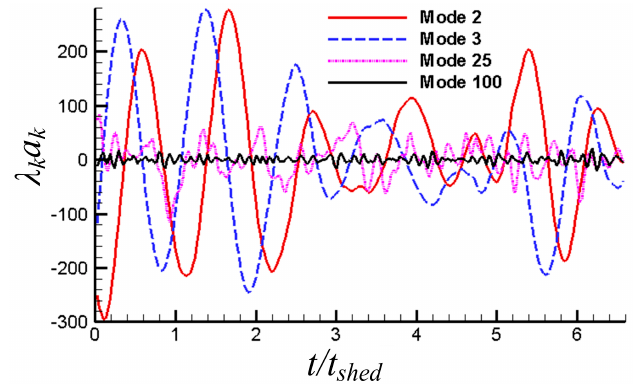
Figure 14. Time-evolution of several typical modal coefficients (modal coefficients vs. normalized time, t shed is the period of the separation vortices without control).